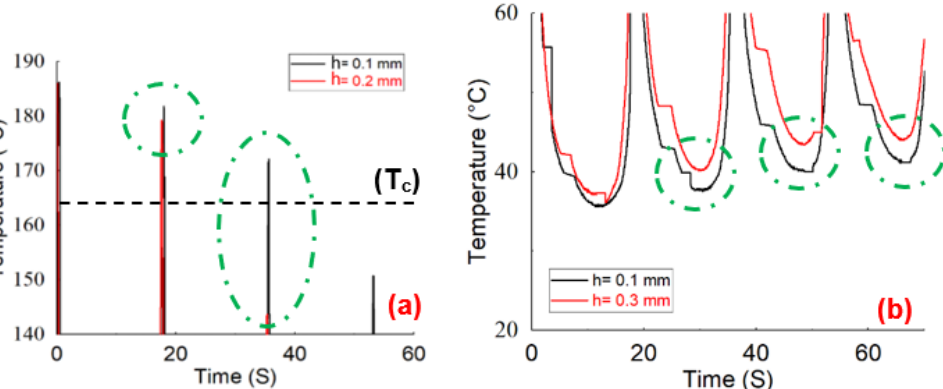
Figure 7. Monitoring of the temperature rise during the additive manufacturing process of CF-PA6 specimens with the different selected layer height values: ( a ) upper limits and ( b ) lower limits.